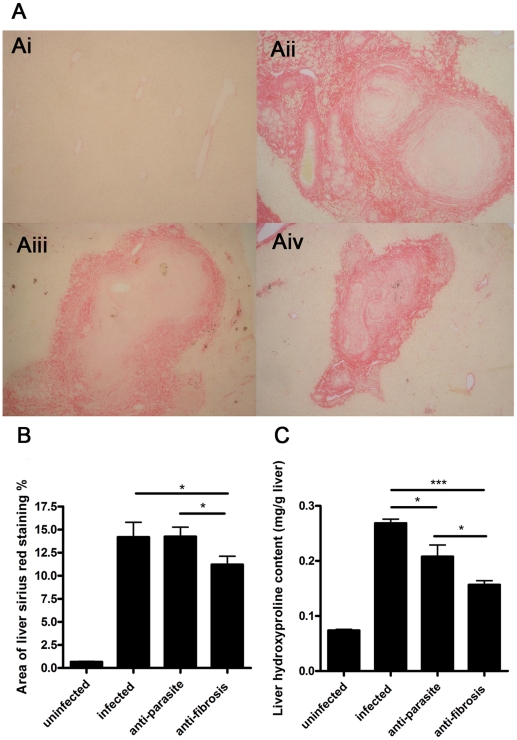
Anti-fibrosis treatment with prizaquantel reduced areas of liver Sirius Red staining and liver hydroxyproline contents of mice 8 weeks post infection with Schistosoma japonicum.(A) Representative images of Sirius Red staining by light microscope (×100). Ai, uninfected; Aii, infected; Aiii, anti-parasite; Aiv, anti-fibrosis. (B) Statistical analysis of scanned images in Sirius Red staining by software IPP6.0. (C) Measurement of liver hydroxyproline content. (* p<0.05, ** p<0.01, *** p<0.001).